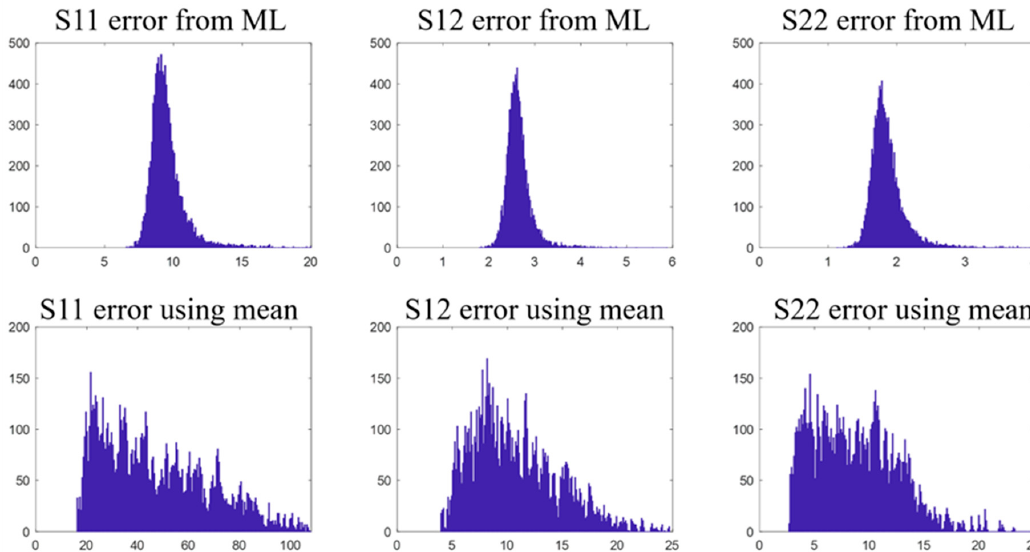
Figure 8. The top row shows the MeanE (kPa) distributions/histograms of S11, S12, and S22 predicted by the 1st ML-model-a. The bottom row shows the MeanE (kPa) distributions of S11, S12, and S22 predicted by using the mean distributions.